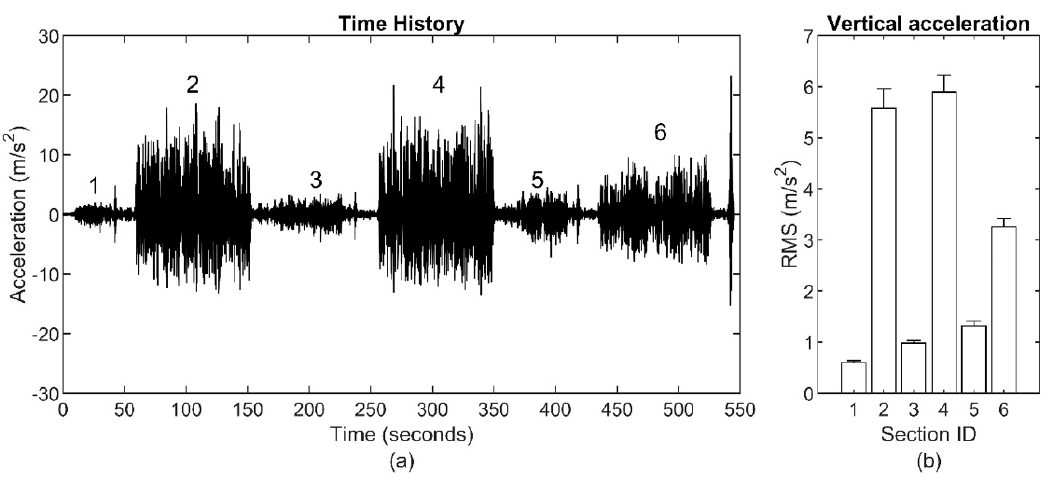
Figure 1. ( a ) Time history profile of the vertical acceleration at the vehicle floor for Subject 12; ( b ) average root mean square (RMS) values and their SDs for vertical acceleration of all subjects for Sections 1–6.